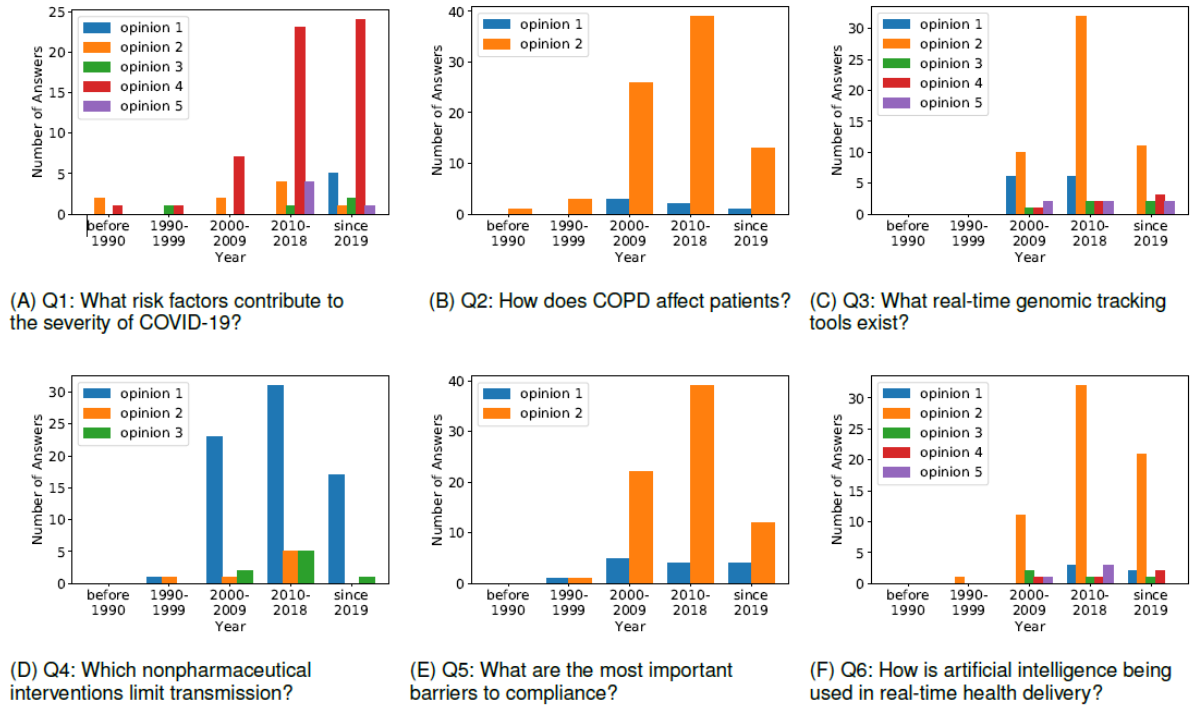
Figure 2. The graphs show the number of articles affiliated with each opinion during different periods for all questions. The numbers are based on all articles. The interpretation of the opinions is shown in Table 1. COPD: chronic obstructive pulmonary